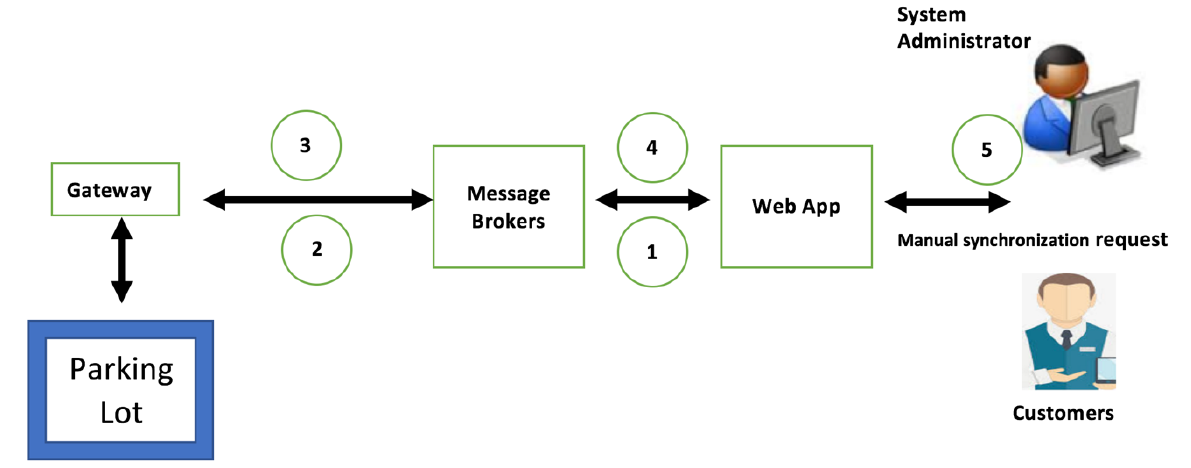
Figure 11. Synchronization process of the state of the parking spaces.